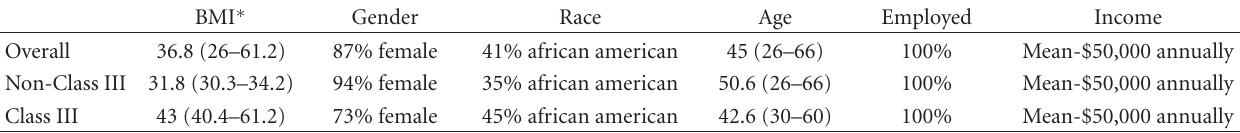
Figure 1: Data collection workflow. Table 2: Sample demographics by BMI